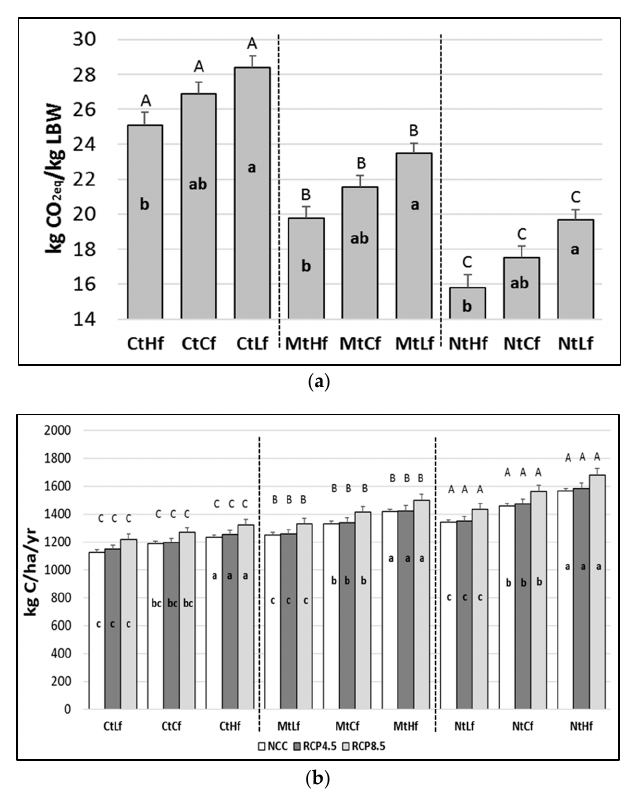
Figure 4. Mean annual (from 2019 to 2089) ( a ) overall carbon footprint ( ±se ) as a result of different tillage types and fertilization rates and ( b ) crop yield ( ±se ) as a result of different tillage types, fertilization rates, and climate scenarios. Cf = current fertilization (50 kg N ha − 1 yr − 1 ); Ct = current tillage; Hf = higher fertilization rate (+50% Cf); Lf = lower fertilization rate ( − 50% Cf); NCC = current climate; RCP4.5 and RCP8.5 = Representative Concentration Pathways 4.5 and 8.5. In Figure 4 a , the letters above the bars indicate differences between each tillage per fertilization rate combination. The letters in bold inside the bars indicate differences between fertilization rates, applied within each tillage. In Figure 4 b , the letters above the bars indicate differences between tillage types for each fertilization rate per climate scenario combination. The letters in bold inside the bars indicate differences between fertilization rates, applied within each tillage per climate scenario combination. Different uppercase letters indicate statistical differences from Tukey’s test ( p < 0.001). Different lowercase letters indicate statistical differences from Tukey’s test ( p < 0.05).